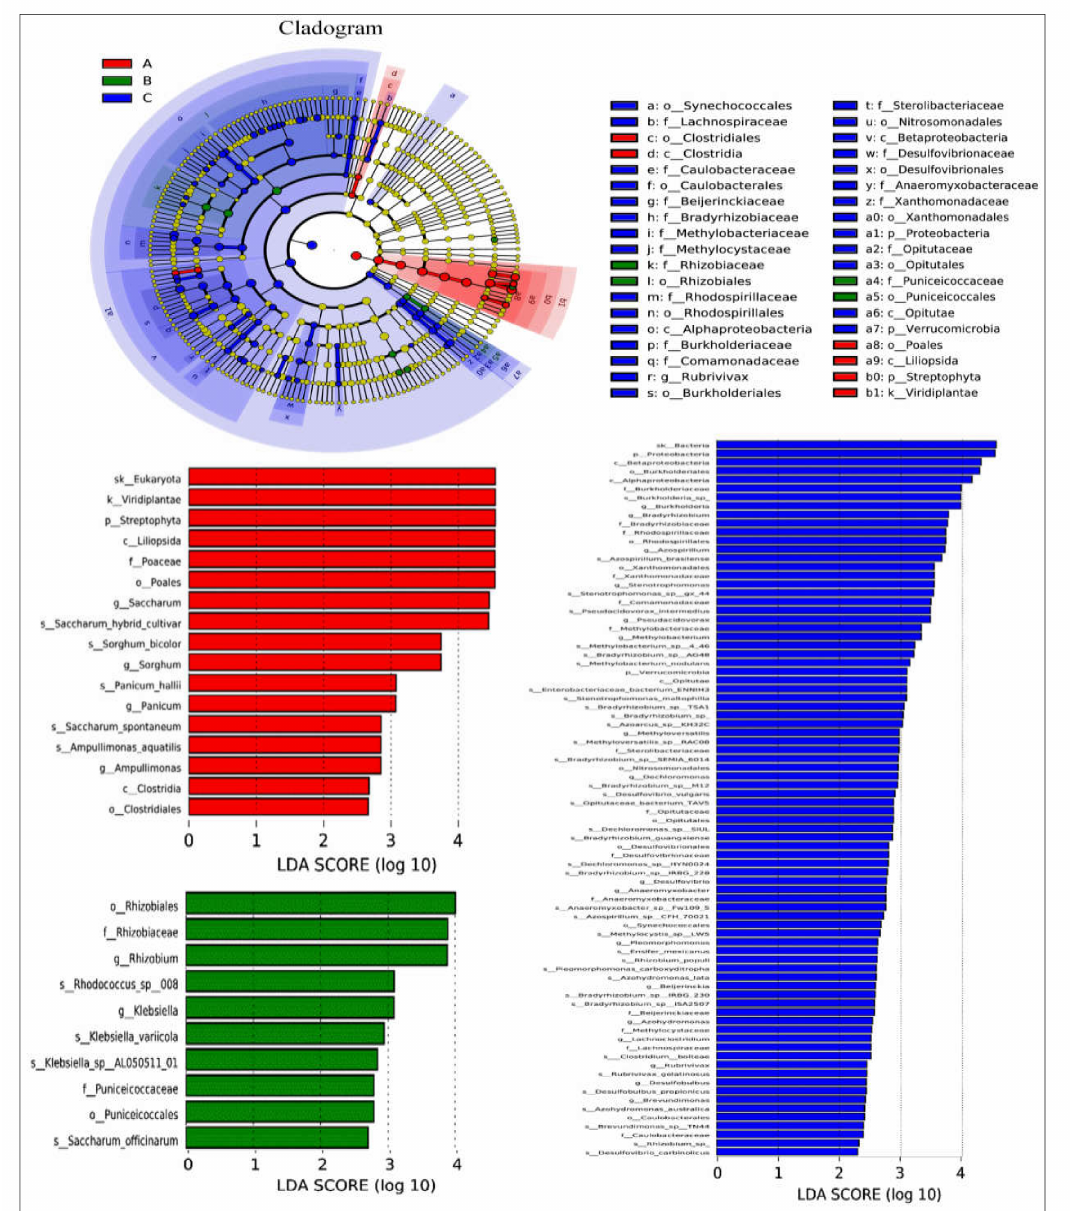
Figure 9. Analysis of community differences between LEfSe groups. LEfSe uses linear discrimi- nant analysis (LDA) to estimate the effect of the abundance of each component (species) on the different